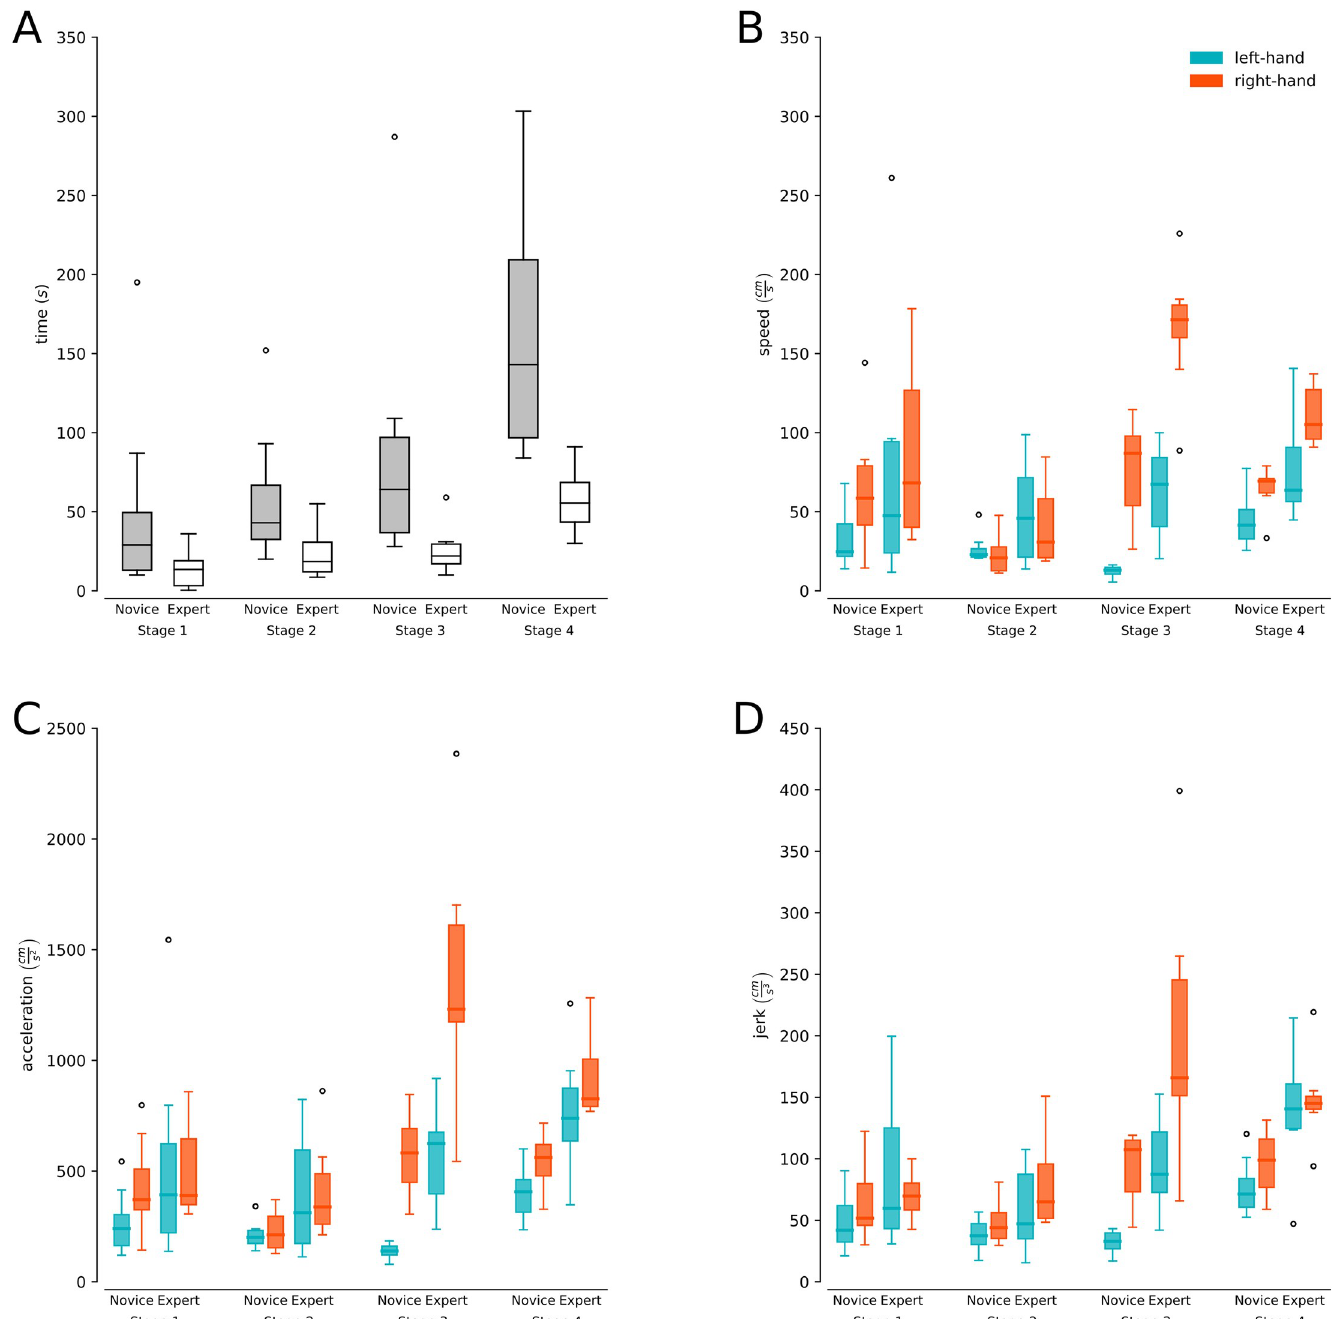
Fig 4. Procedural time and biomechanical variables. (A) Duration (y-axis) for each of the stages of the CVA simulation for experts (gray boxes) and novices (white boxes). (B and C) Speed, acceleration, and jerk (y-axis) for each of the CVA simulation stages for experts and novices separated by hand (light blue boxes left hand and orange boxes right